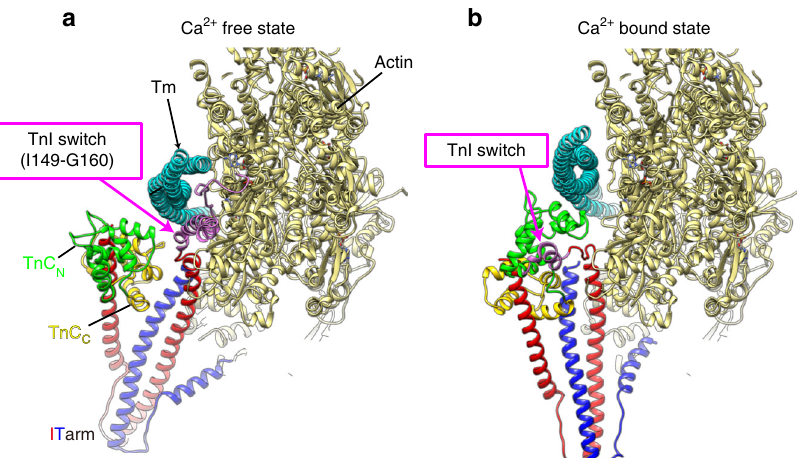
Fig. 6 Structural changes of the thin fi lament and Tn complex upon Ca 2 + binding to TnC. a Ca 2 + free state, b Ca 2 + bound state. Model colors are the same as in Fig. 3 except for TnC C colored brown. The models are viewed obliquely from the pointed end of actin fi lament.